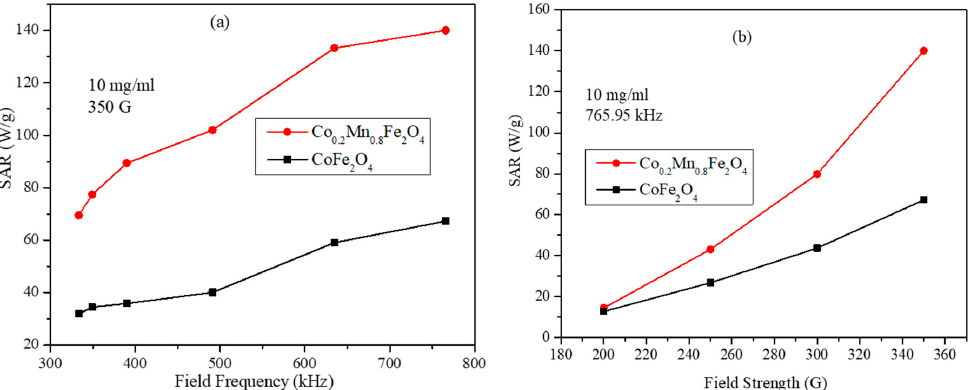
Figure 12. ( a ) SAR values as a function of AMF frequency at field strength of 350 G for 10 mg/mL of CoFe 2 O 4 and Co 0.2 Mn 0.8 Fe 2 O 4 nanoparticles and agar ferrogel. ( b ) SAR values as a function of field strength at fixed AMF frequency of 756.95 kHz for 10 mg/mL of CoFe 2 O 4 and Co 0.2 Mn 0.8 Fe 2 O 4 nanoparticles and agar ferrogel (lines are just guides for the